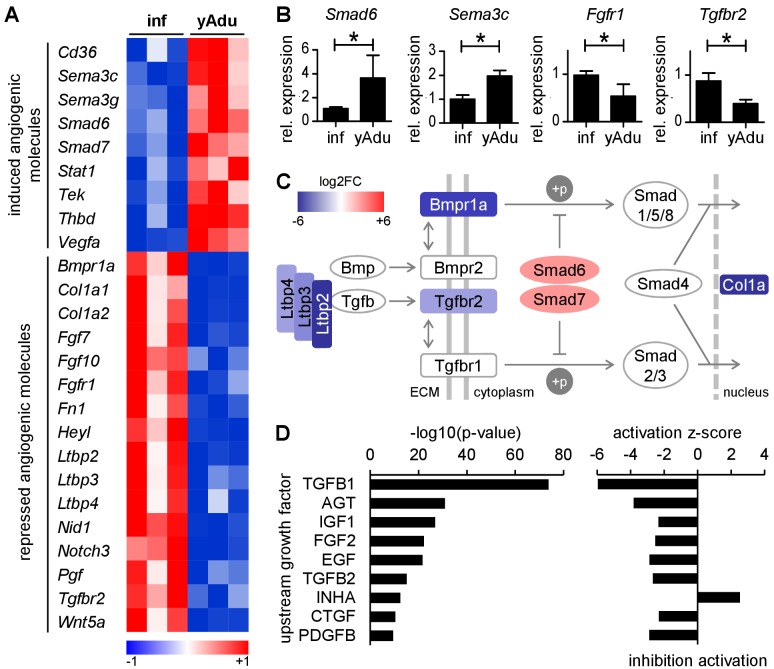
TGFß family signaling is inhibited in quiescent EC.(A) Heatmap depicting the expression of anti- and pro-angiogenic molecules during the acquisition of vascular quiescence. Depicted are significantly regulated genes (p<0.05) that are differentially expressed by at least 1.75 fold. (B) Validation of the expression pattern of anti- and pro-angiogenic molecules in lung EC by qPCR in independent biological samples. n ≥ 3; mean ±SD; *p<0.05; Mann-Whitney Test. (C) Schematic representation of the regulation of TGFβ family signaling molecules during acquisition of vascular quiescence emphasizing the overall inhibition of this pathway. Shown by color-code is the gene regulation of individual TGFβ family pathway members (red, upregulated; blue, downregulated; log2FC: log2 fold change). Ltbp: latent TGF-beta binding protein; Bmpr1a: Bone Morphogenetic Protein Receptor Type 1A/Alk3; Bmpr2: Bone Morphogenetic Protein Receptor Type 2; Tgfbr2: Transforming Growth Factor Beta Receptor 2; Tgfbr1: Transforming Growth Factor Beta Receptor 1/Alk5; Smad6 and Smad7: inhibitory SMADs; Smad1/5/8 and Smad2/3: receptor-regulated SMADs; Smad4: Co-SMAD; Col1a: TGFß target gene Collagen type I alpha. (D) Upstream growth factor analysis with activation state prediction of all differentially expressed genes during transition to EC quiescence. Depicted are the transformed (-log10) p-value and the predicted activation state (z-score) of the upstream growth factor according to Ingenuity Pathway Analysis. See methods section for further details. The following figure supplements are available for Figure 2.